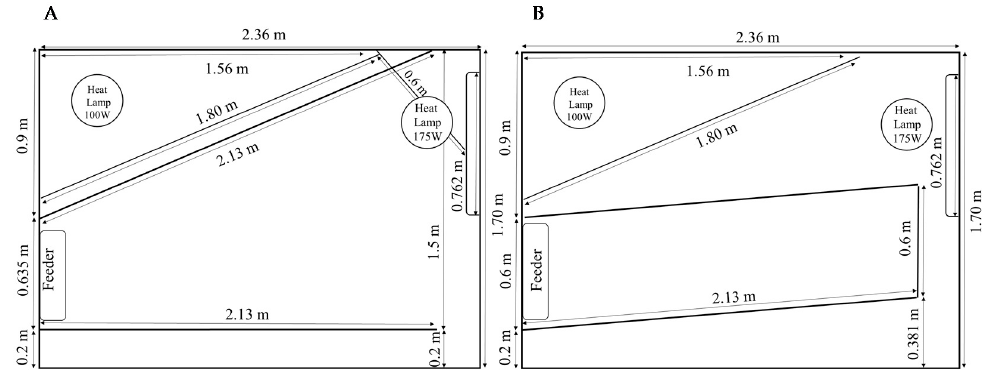
Figure 1. Schematic of pen equipped with a hinged farrowing crate. ( A ) Open. ( B ) Closed. Table 1. Descriptive statistics for the number of sows and farrowing performance across treatment groups. All variables were collected prior to litter equalization on Day 1 and prior to treatment application on Day 4 or Day 7. Real means ±